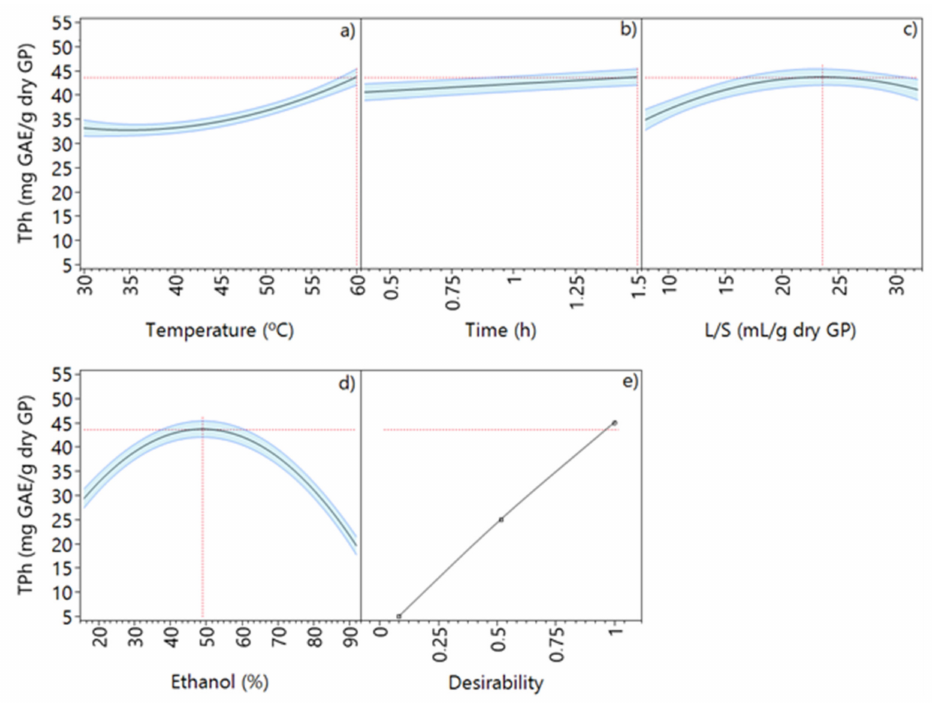
Figure 4. Total phenolic content prediction profiler of ethanol extraction at optimized conditions: ( a ) temperature, ( b ) time, ( c ) liquid–solid ratio, ( d ) ethanol concentration, and ( e ) maximized